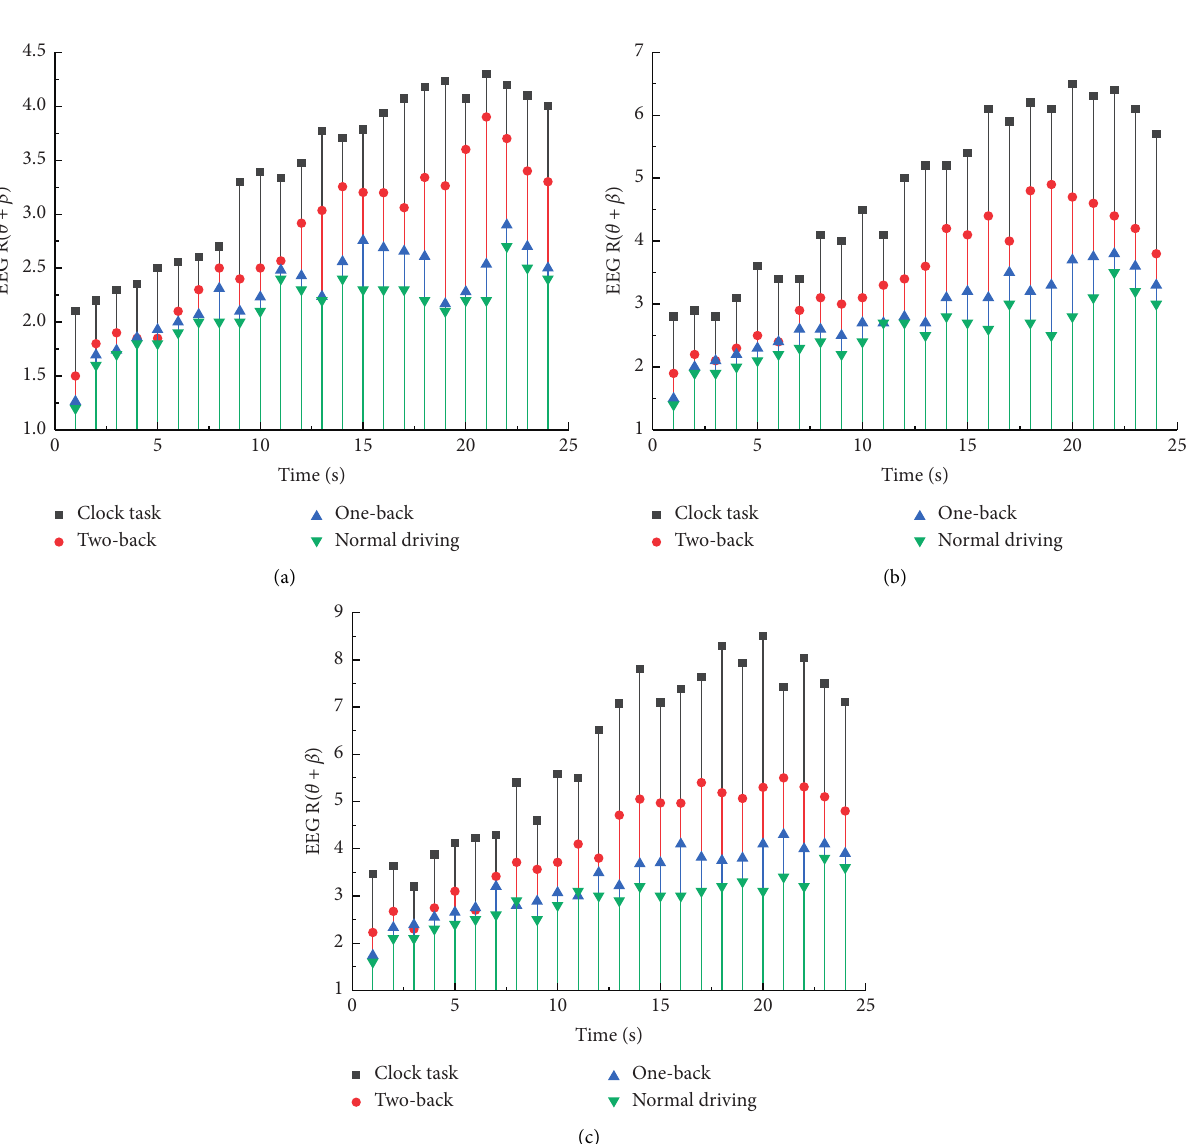
Figure 6: EEG index R ( θ + β ) values of the three events in different secondary tasks, (a) participant’s cognitive load graph for event one, (b) participant’s cognitive load graph for event two, and (c) participant’s cognitive load graph for event